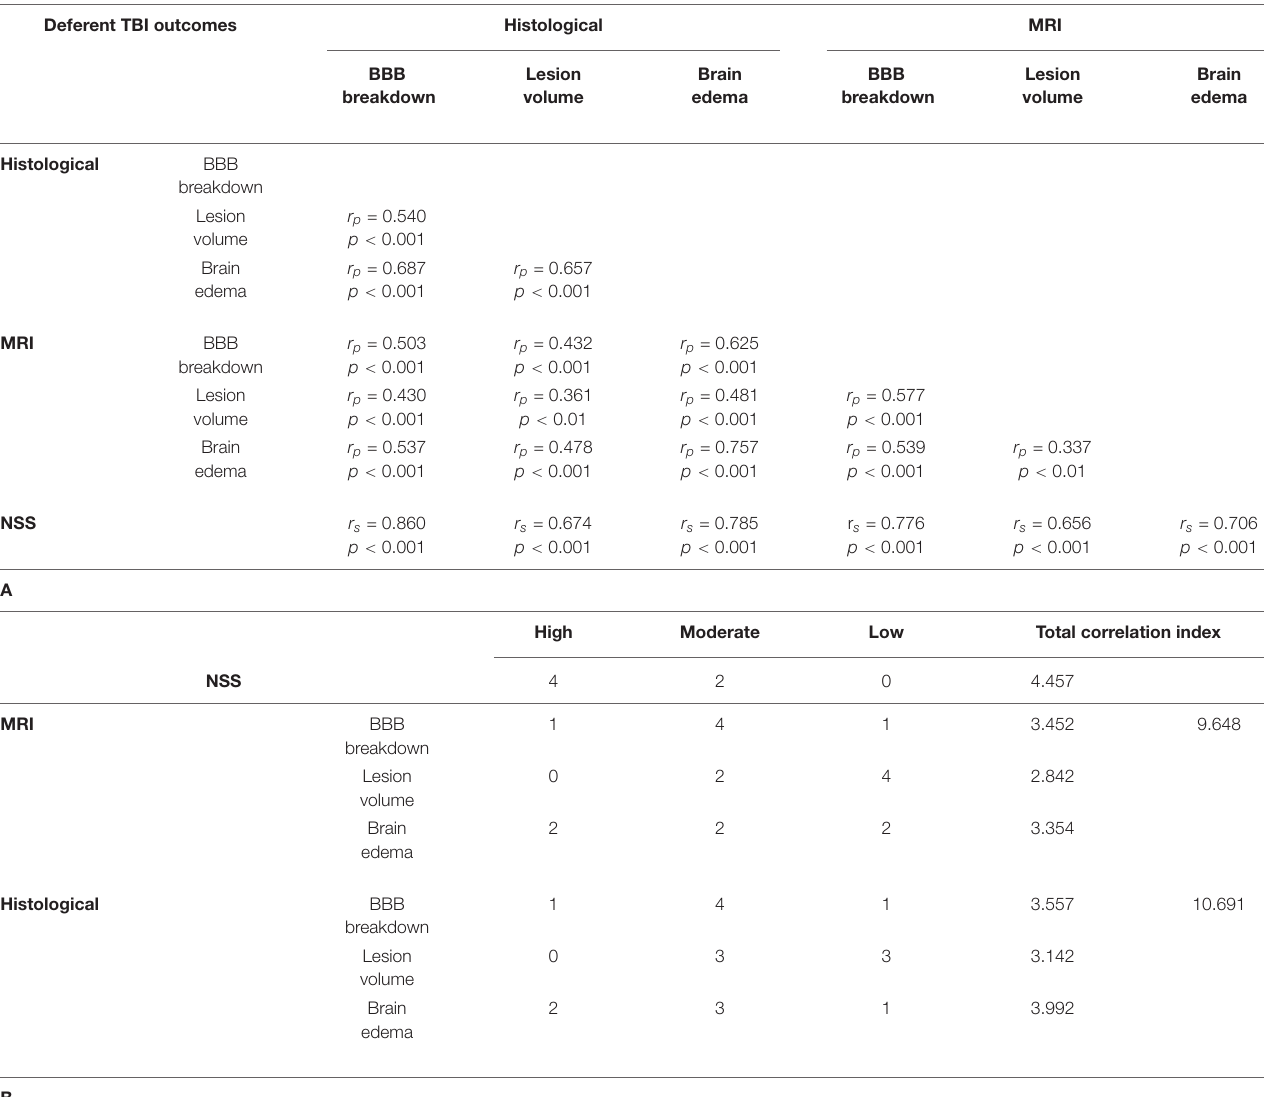
TABLE 3 | Comparisons between the different measurements of TBI severity outcome. (A) Comparison of the correlation between the different parameters of TBI severity outcome 48 h after TBI by either histological and MRI-determined techniques. (B) Determination of the outcomes with the highest correlation values. Deferent TBI